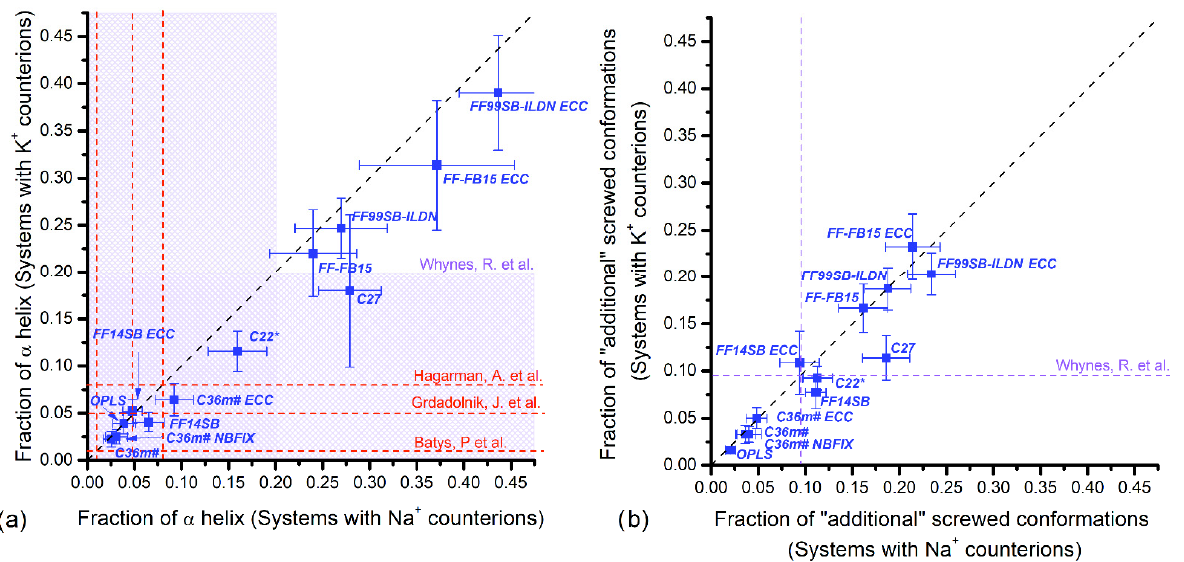
Figure 6. PGA: Fractions of ( a ) α R -helical and ( b ) 3.10-helical conformations (for CHARMM force fields) and the “additional screw” conformations (for AMBER and OPLS force fields) with Na + coun- terions versus K + counterions. Vertical and horizontal dashed lines and shadowed areas correspond to available experiment data.